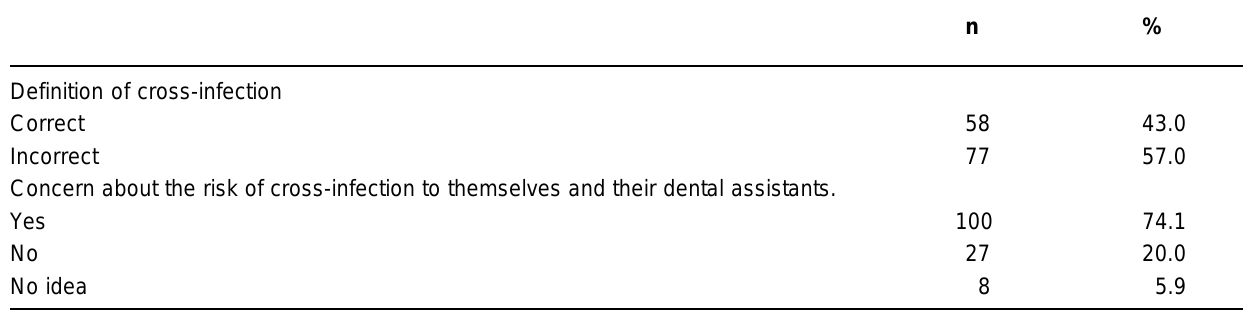
TABLE 2- Definition and concern about cross-infection